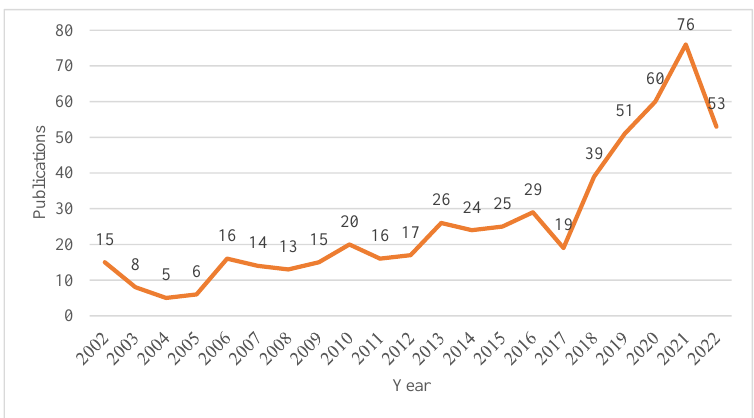
Figure 3. The number of selected journal papers published each year.